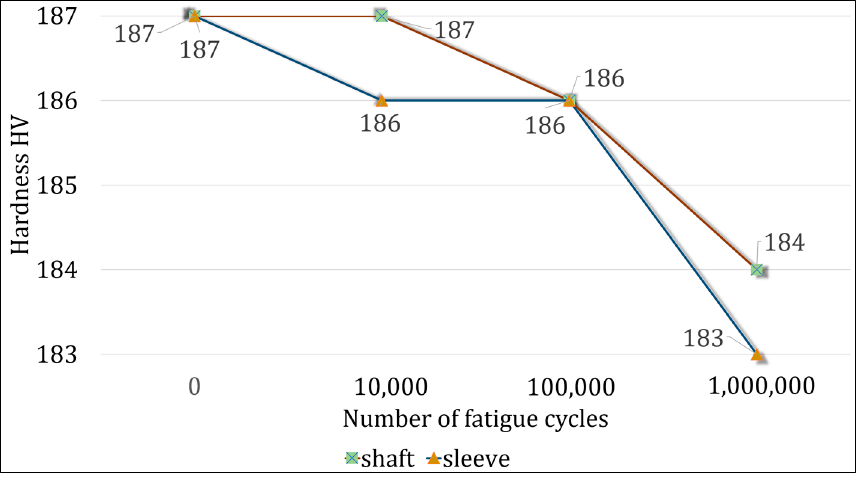
Figure 7. Change of shaft and sleeve hardness depending on the number of fatigue cycles.